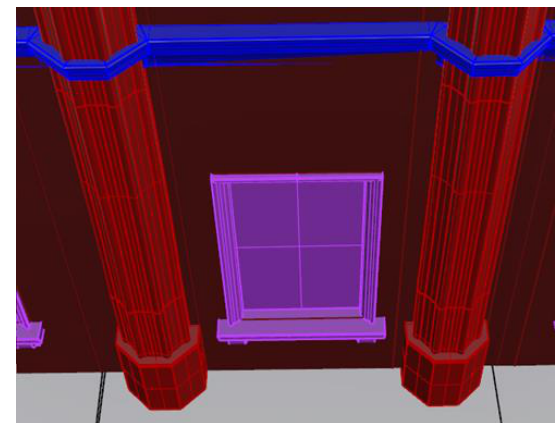
Figure 16: Detail of the solid modeling of columns and windows of the